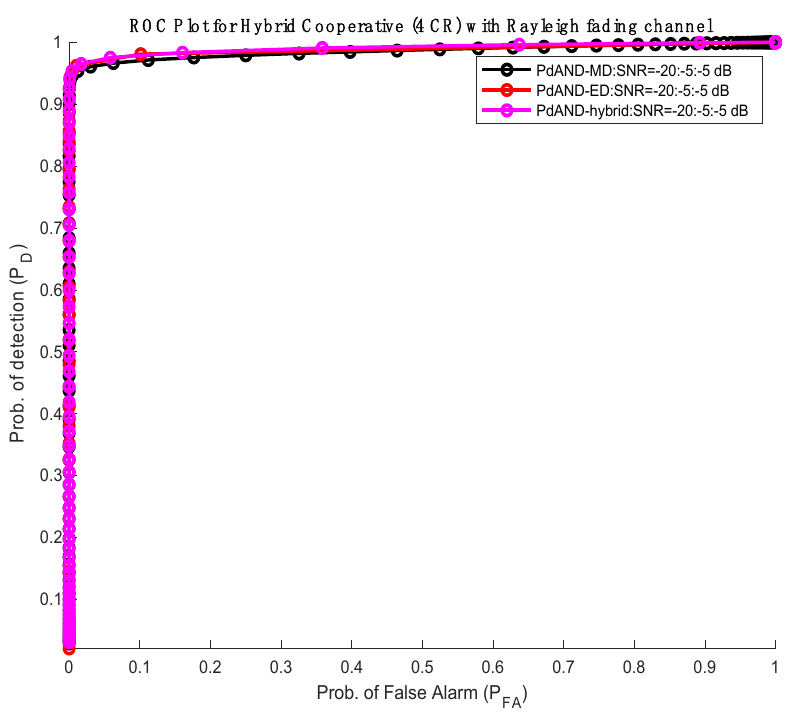
Figure 7. Hybrid detector under CSS (4): AND for case 1.